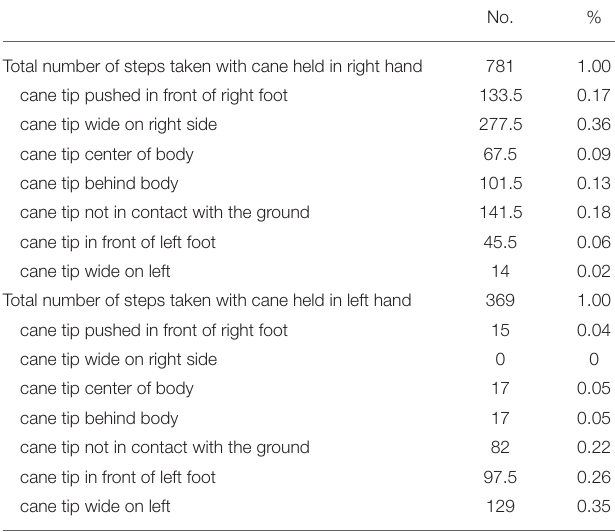
TABLE 2 | Number and percentage of steps taken and cane tip placement.